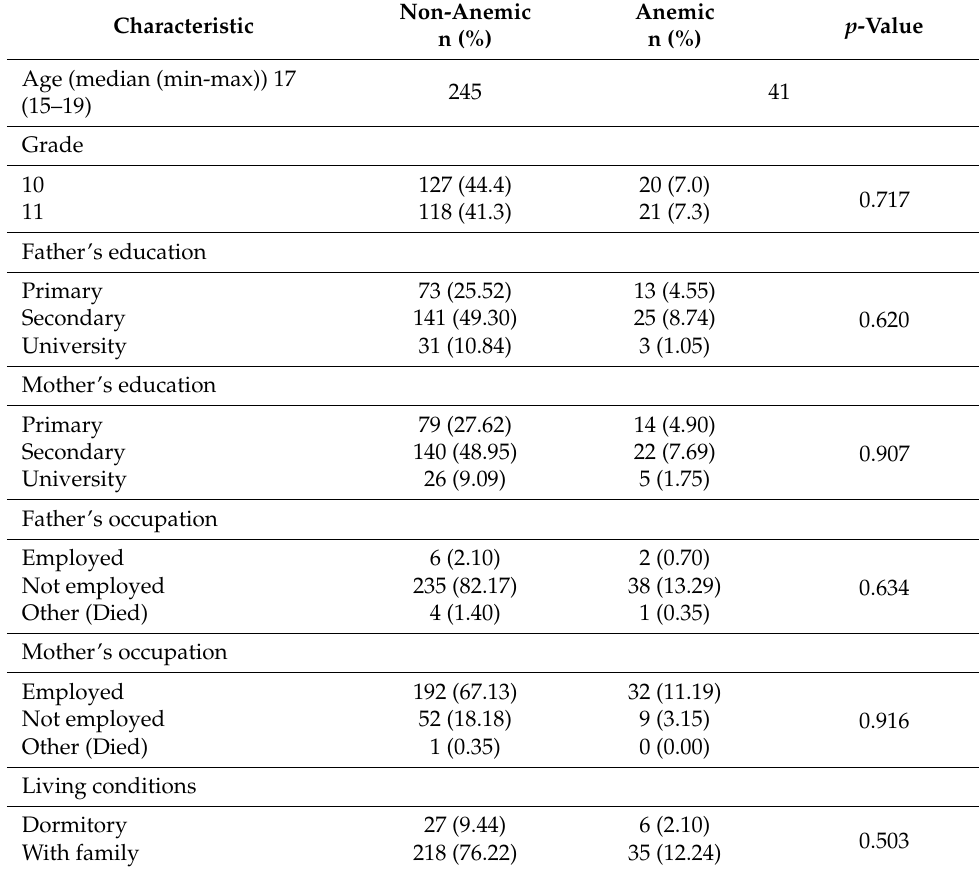
Table 1. Participants